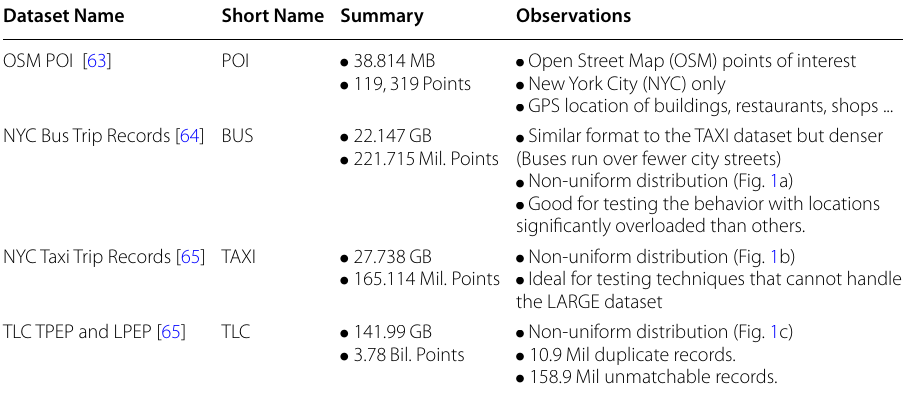
Table 4 Experimental dataset summary sorted by the dataset’s file